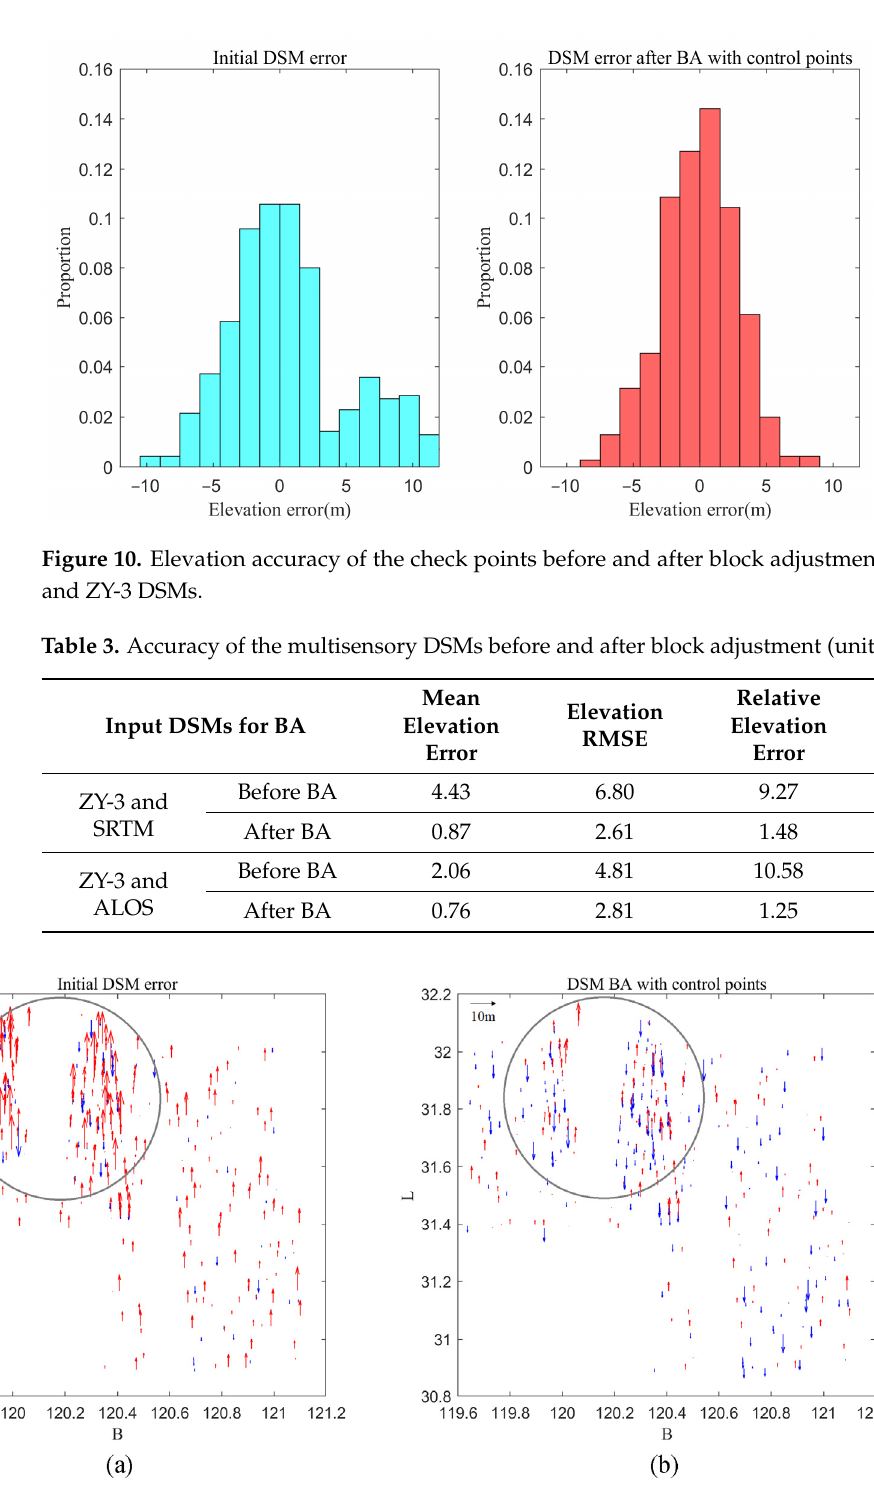
Figure 9. DSM comparison before and after the block adjustment for the ALOS and ZY-3 DSMs with the ellipses indicating the areas of significant difference. ( a ) Before block adjustment, and ( b ) after block adjustment.